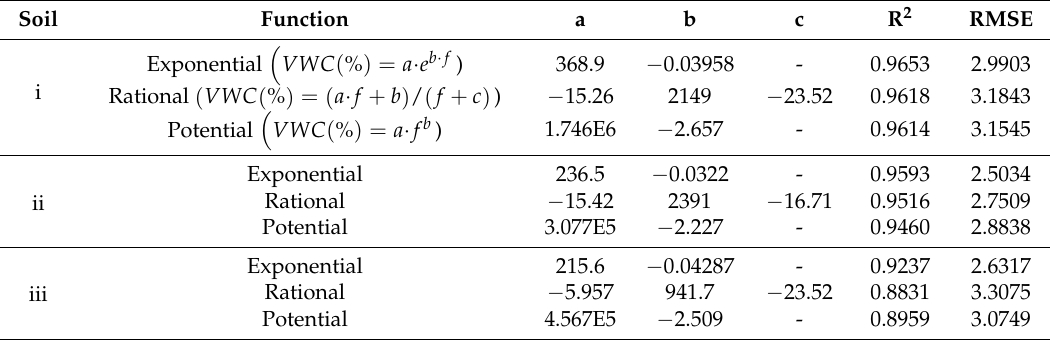
Table 2. Parameters of calibration functions, determination coefficient (R 2 ) and root mean square error